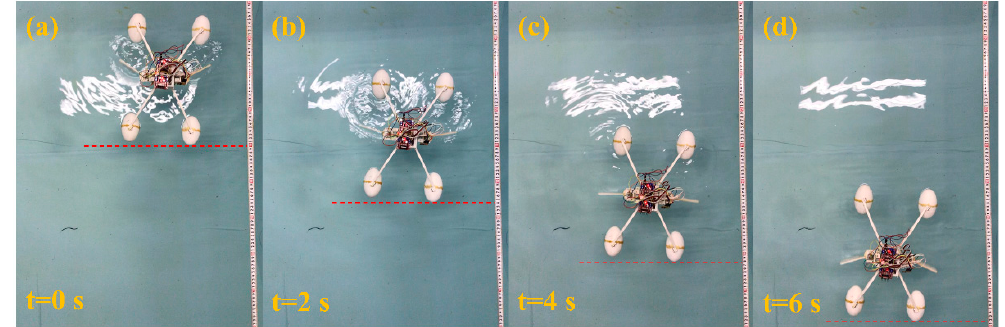
Figure 20. The positions of the robot at different times t: ( a ) 0 s, ( b ) 2 s, ( c ) 4 s, and ( d ) 6 s, when the robot is moving forward with the stroke cycle T = 2.0 s.